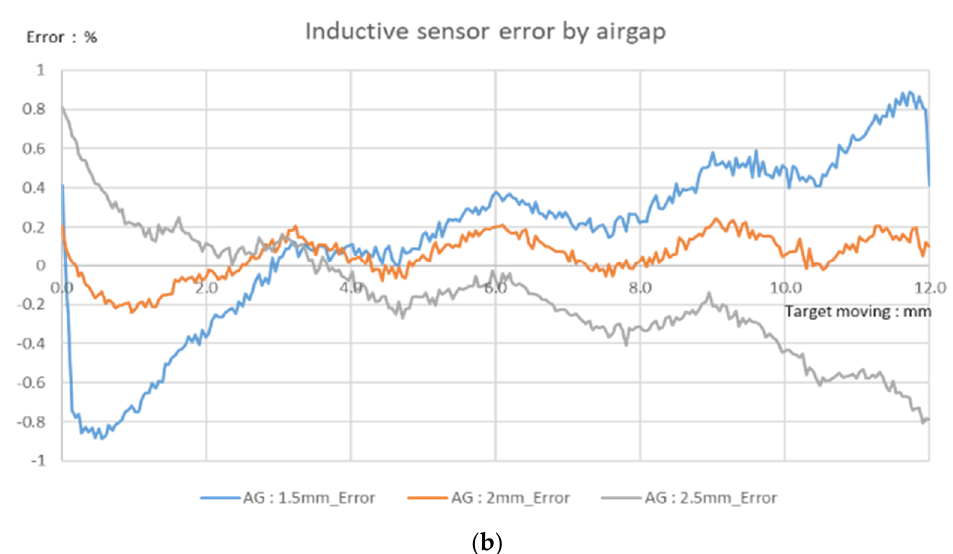
Figure 11. Stroke test results for ZMID5201 inductive position sensor (IPS): ( a ) Output voltage vs. distance for different airgaps (AGs). ( b ) Corresponding error result. IPS meets the error limit of ±1%; the actual error is within ±0.85% at room temperature (25 °C).